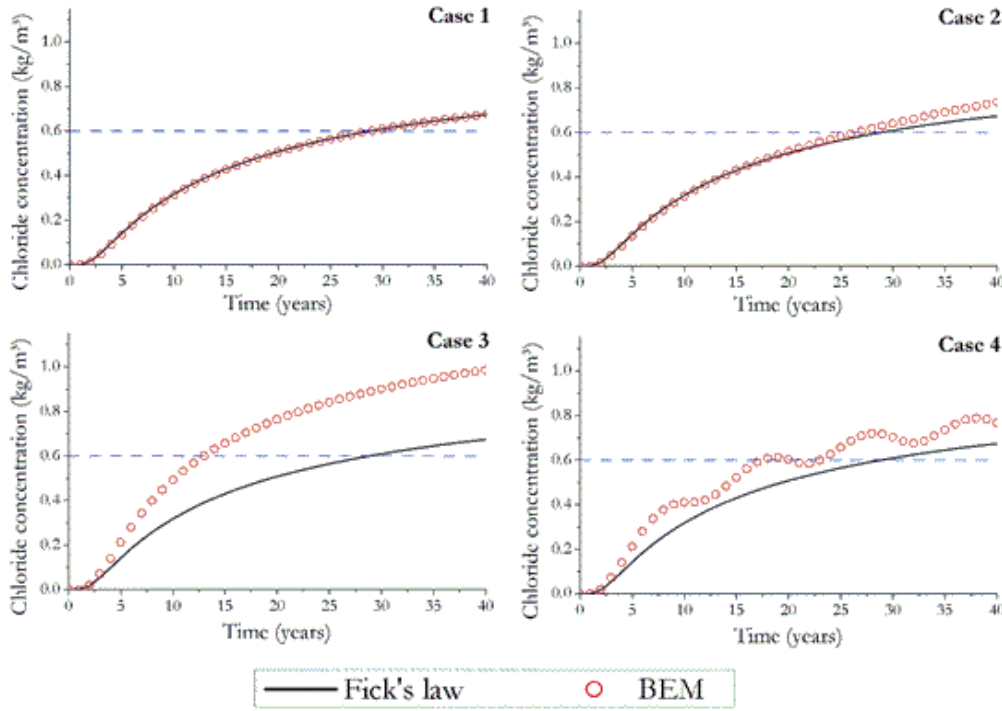
Figure 8 – Chloride concentration evolution along time for the fixed